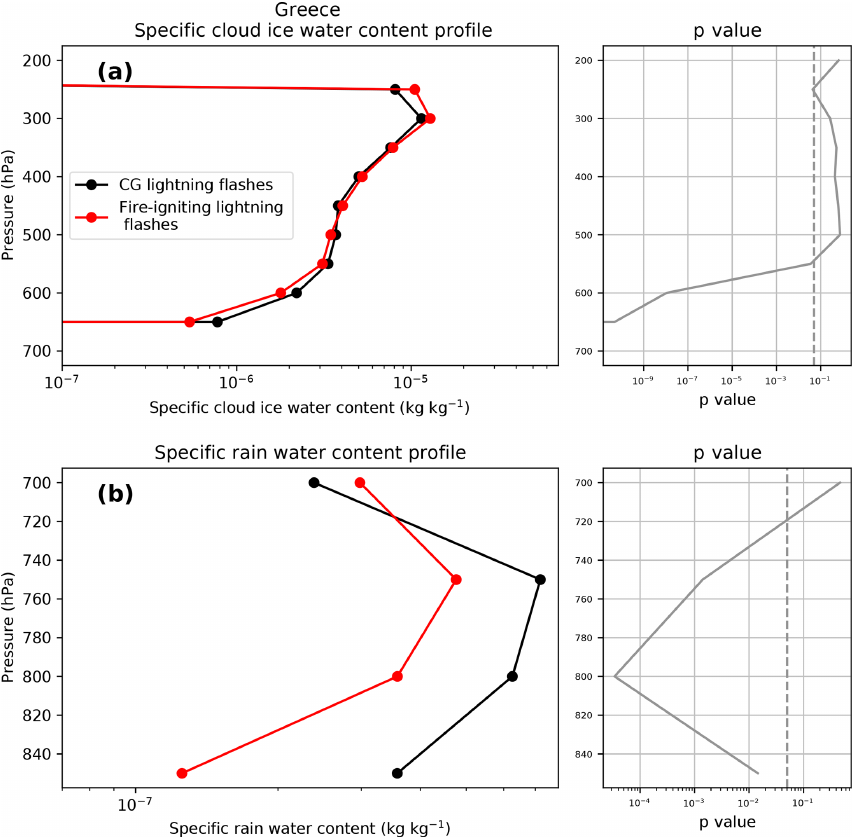
Figure 9. The first column shows the vertical profiles of the specific cloud ice water content (a) and the specific rain water content (b) for the CG lightning and the fire-igniting lightning climatologies during May and September in Greece between 2017 and 2019. The second column shows the p value (solid line) for each vertical level, representing the probability of equal median between both distributions, and a mark showing the limit at 0.05 (dashed